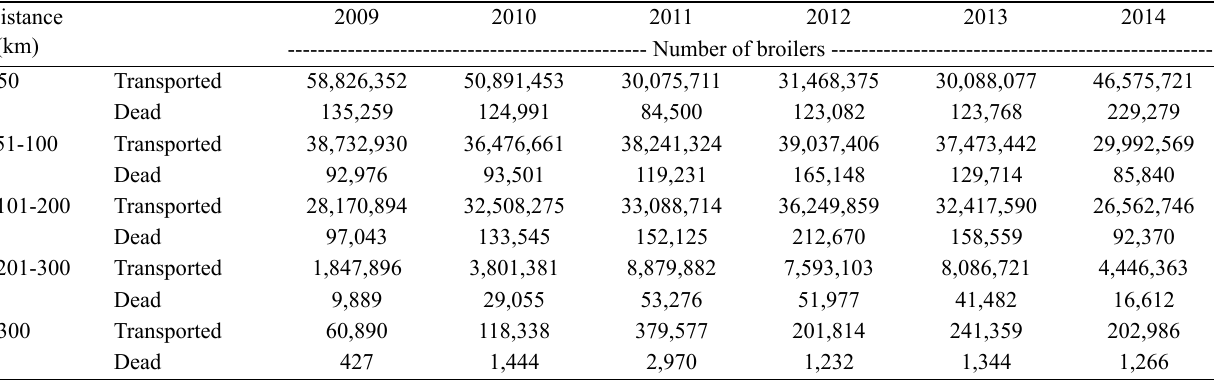
Table 1. The numbers of broiler chickens transported to poultry processing plants and numbers of birds dying as a result of their transport for monitored distances Distance